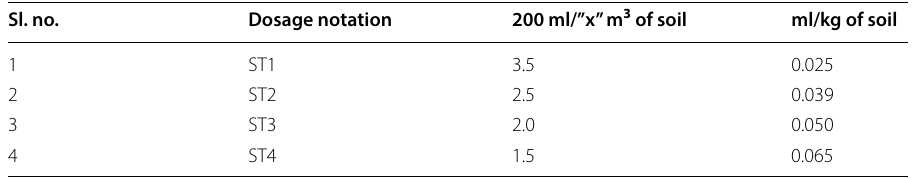
Table 2 Dosages of enzymes used in the present study Sl.